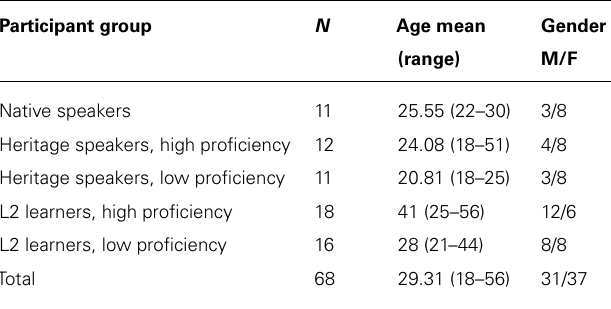
Table 1 | Background information of the participants in the